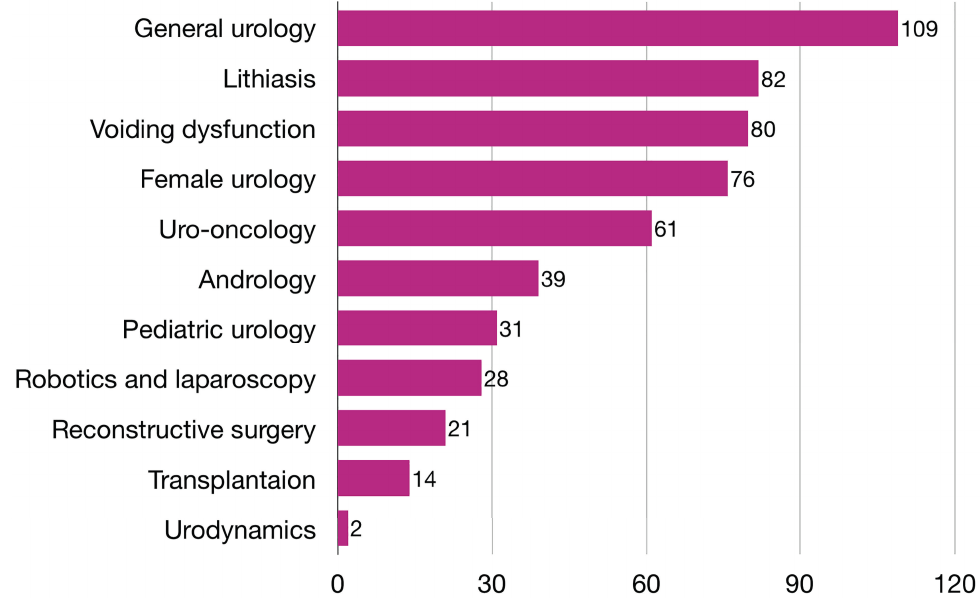
Figure 1 - Subarea of urological expertise reported by the